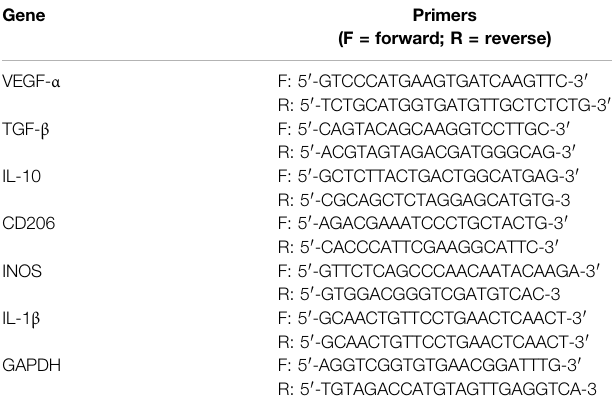
TABLE 1 | Primer squences for real-time PCR. TABLE 2 | Primer squences for real-time PCR. Gene Primers Gene Primers (F = forward; R = reverse) (F = forward; R =